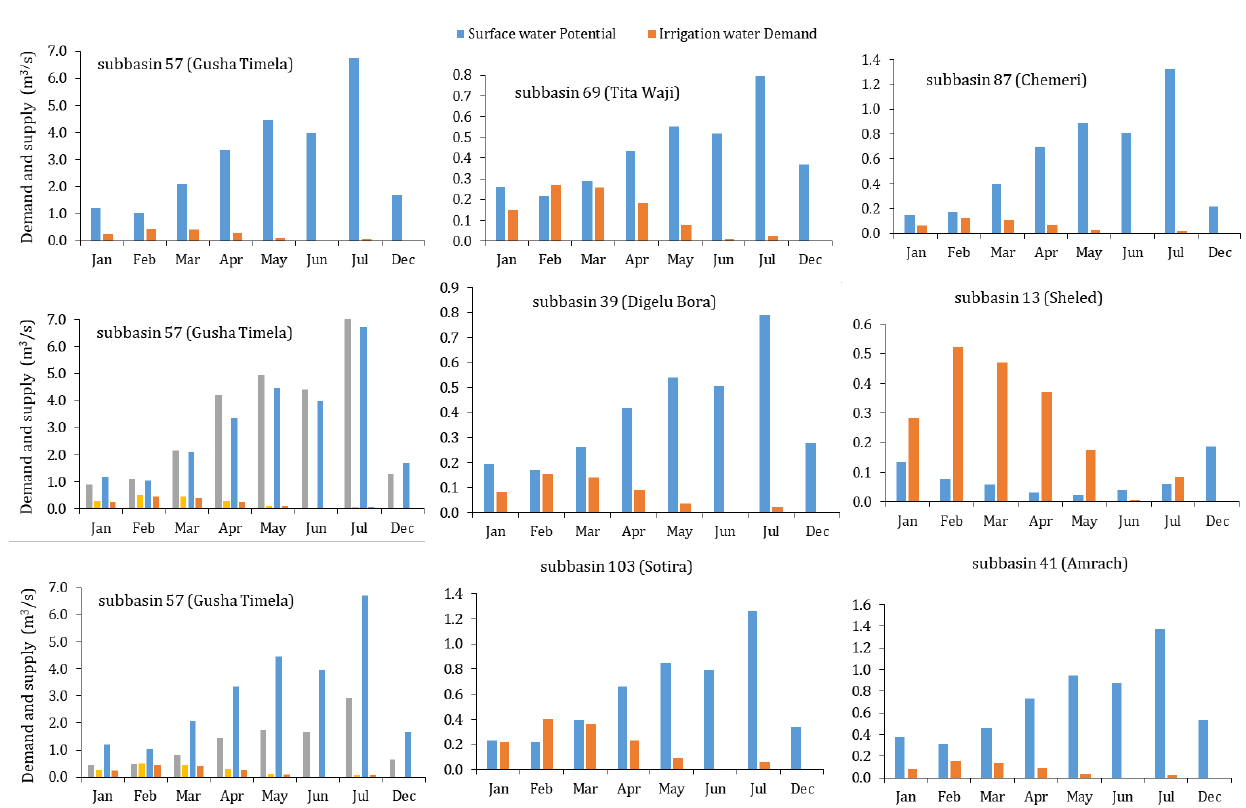
Figure 10. Irrigation water demand (orange color) and surface water potential (blue color) at the basin scale of where an irrigation system is developed in 104 cubic meters.